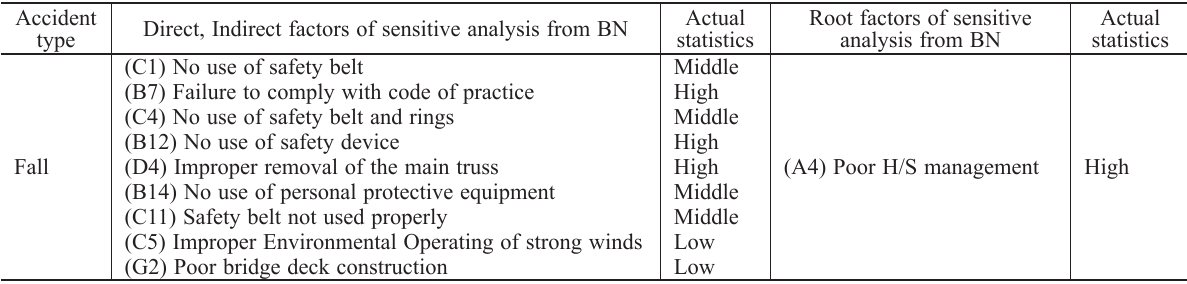
Table 7. Comparison of sensitive factors from BN and actual statistics Accident type